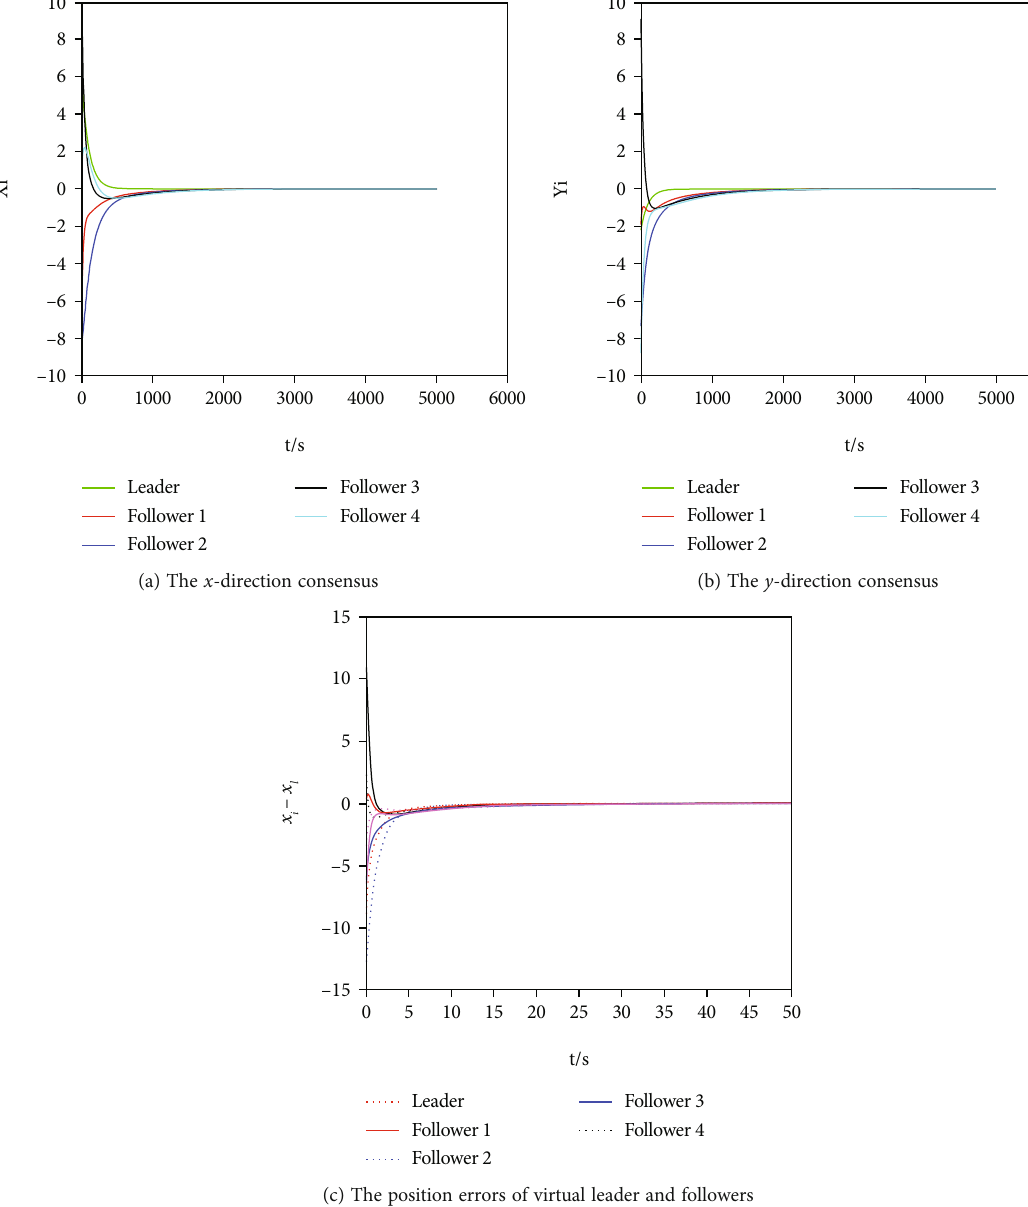
The outer ring of the obstacle indicates the detection region radius r , and the inner ring indicates the critical col- s . lision radius r a